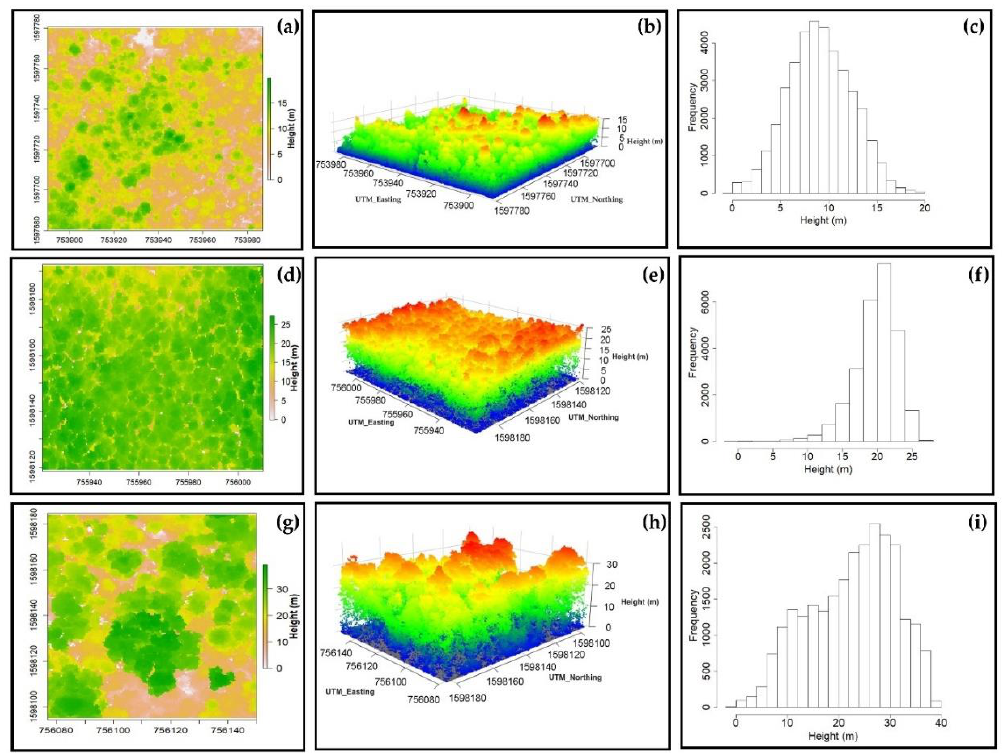
Figure 4. Example of the characteristics of the three forest successional stages. Each row represents the Canopy height Model (CHM), three-dimensional (3D) point clouds, and canopy height distribution of each stage, respectively. ( a – c ) represent the characteristics of SIS. ( d – f ) represent the characteristics of SES. ( g – i ) represent the characteristics of OGS.